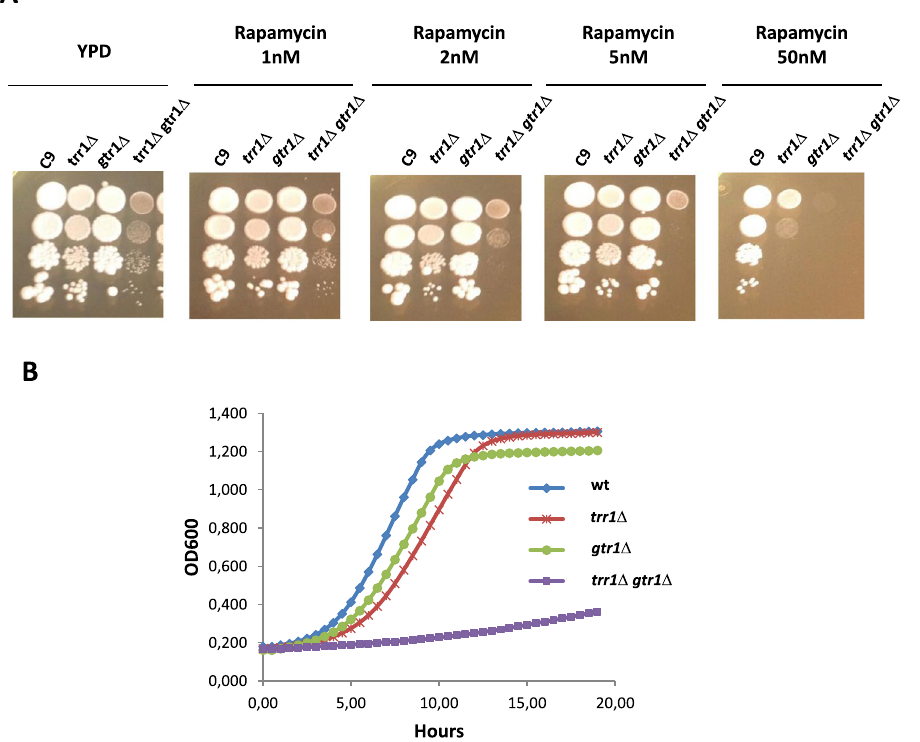
Figure 7. TRR1 and the GTPase GTR1 interact genetically. ( A ) The spot analysis of different amounts of rapamycin of the single trr1 Δ and gtr1 Δ mutants, and the double trr1 Δ gtr1 Δ mutant in strain C9. ( B ) Growth curves in the YPD rich medium of the strains used in section ( A ) performed by a Varioskan Lux plate reader at 30 °C with